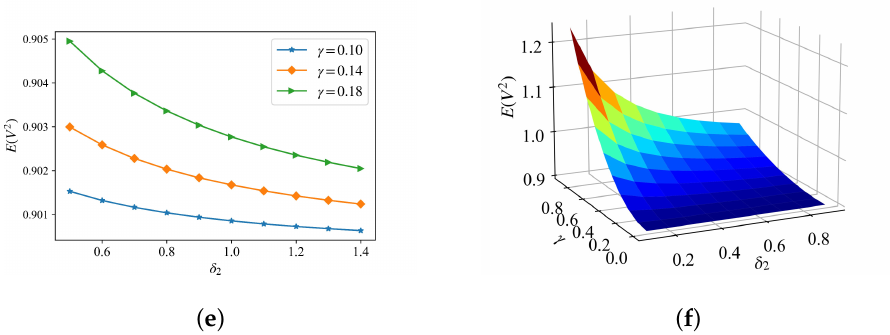
Figure 6. The variations in the mean square voltage with different noise intensities γ , electromechani- cal coupling coefficient θ , piezoelectric coupling term λ and nonlinear stiffness coefficient δ 2 ( β = 2.0). ( a , b ): γ and θ , where λ = 0.5 and δ 2 = 1.0. ( c , d ): γ and λ , where θ = 0.5 and δ 2 = 1.0. ( e , f ): γ and δ 2 , where θ = 0.5 and λ = 0.5.